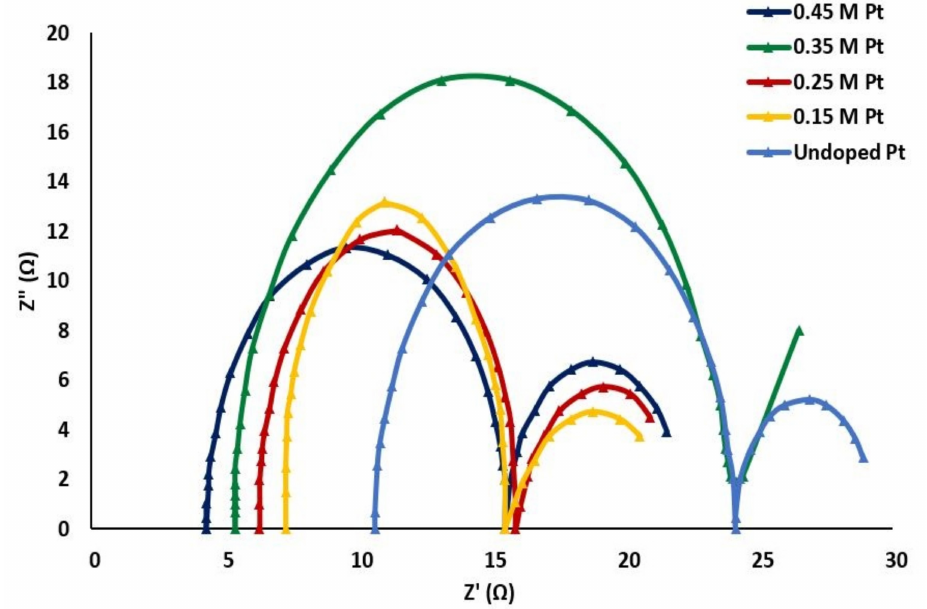
Figure 8. Nyquist plot of undoped TiO 2 and Pt-doped TiO 2 at different molar